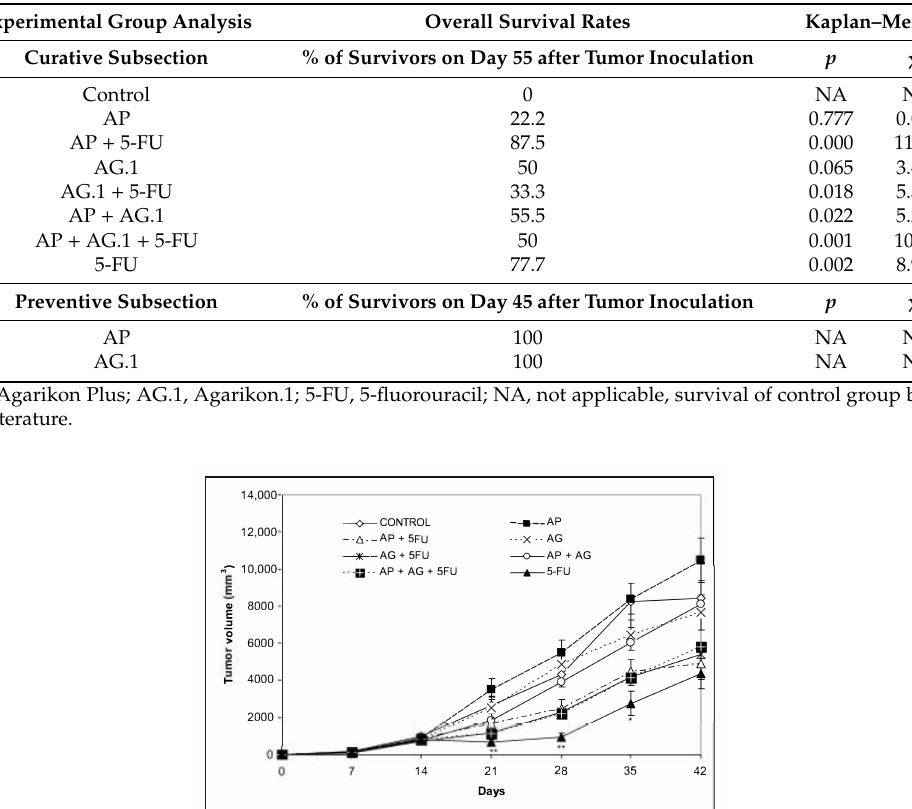
Table 3. Survival analysis of Balb / c mice bearing CT.26.WT after treatment.